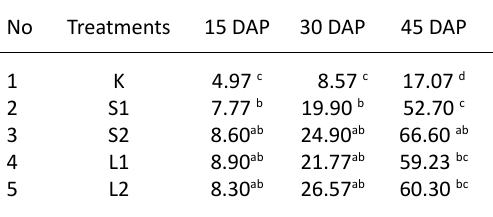
Table 1. Plant height (cm) treated by induced compost of cellulolytic and ligninolytic fungi inoculum No Treatments 15 DAP 30 DAP